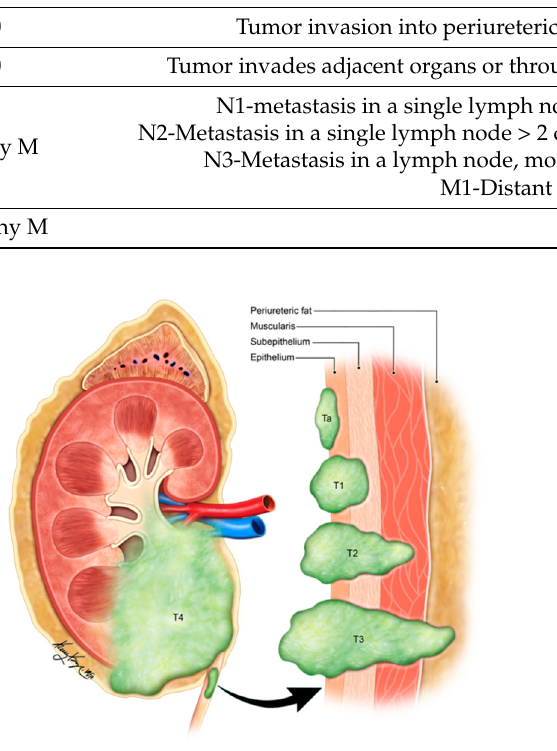
Figure 15. Illustration demonstrating the staging of ureteral carcinoma. Ta: non-invasive papillary tumor; T1: tumor invasion into sub-epithelial connective tissue through lamina propria; T2: tumor invasion into muscularis propria; T3: tumor invasion into periureteric fat beyond muscularis propria; T4: tumor invades adjacent organs or through the kidney into the perinephric fat.